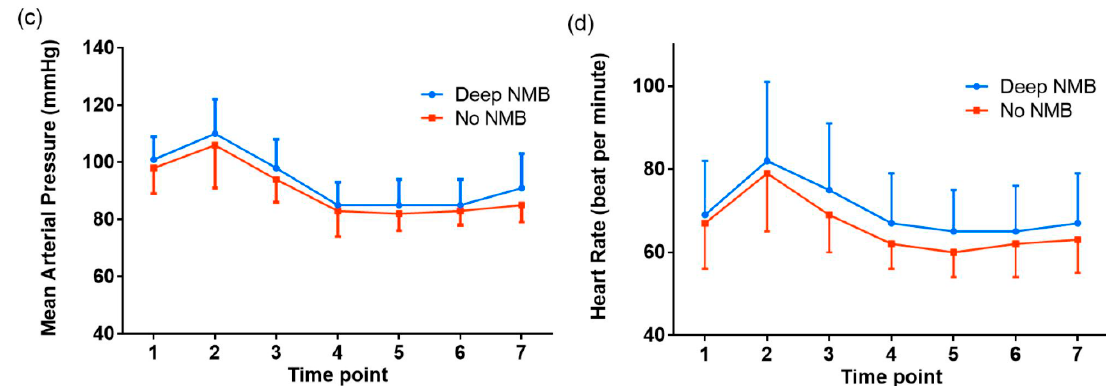
Figure 3. The change over time in ( a ) train-of-four (TOF) ratio, ( b ) bispectral index (BIS), ( c ) mean arterial pressure and ( d ) heart rate at the main time points during the perioperative period. NMB: neuromuscular blockade. The graphs show the mean value and standard deviation of each variable for each time point during general anesthesia. Time point 1: at baseline (before anesthesia), 2: at intubation, 3: at skin incision, 4: 30 min after skin incision, 5: 60 min after skin incision, 6: 120 min after skin incision, 7: at the end of surgery. * p < 0.001.